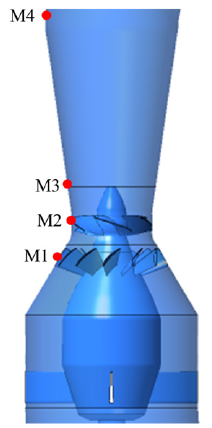
Figure 12. Schematic of the monitoring point layout.